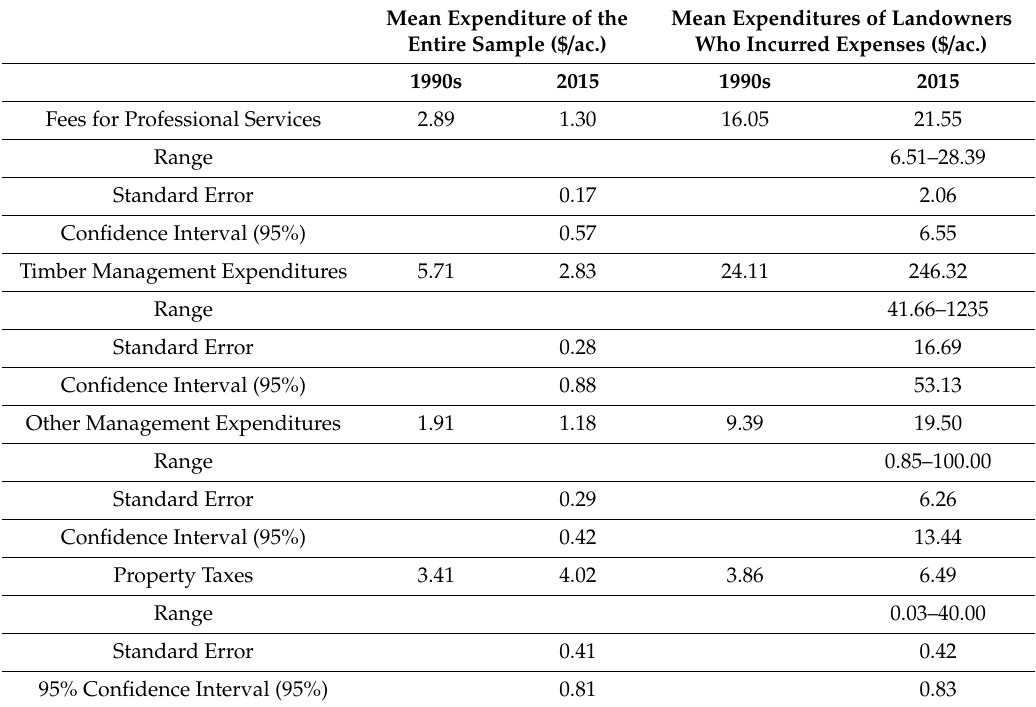
Table 4. Overall Expenditures in forest management activities by landowners in the 1990s and 2015